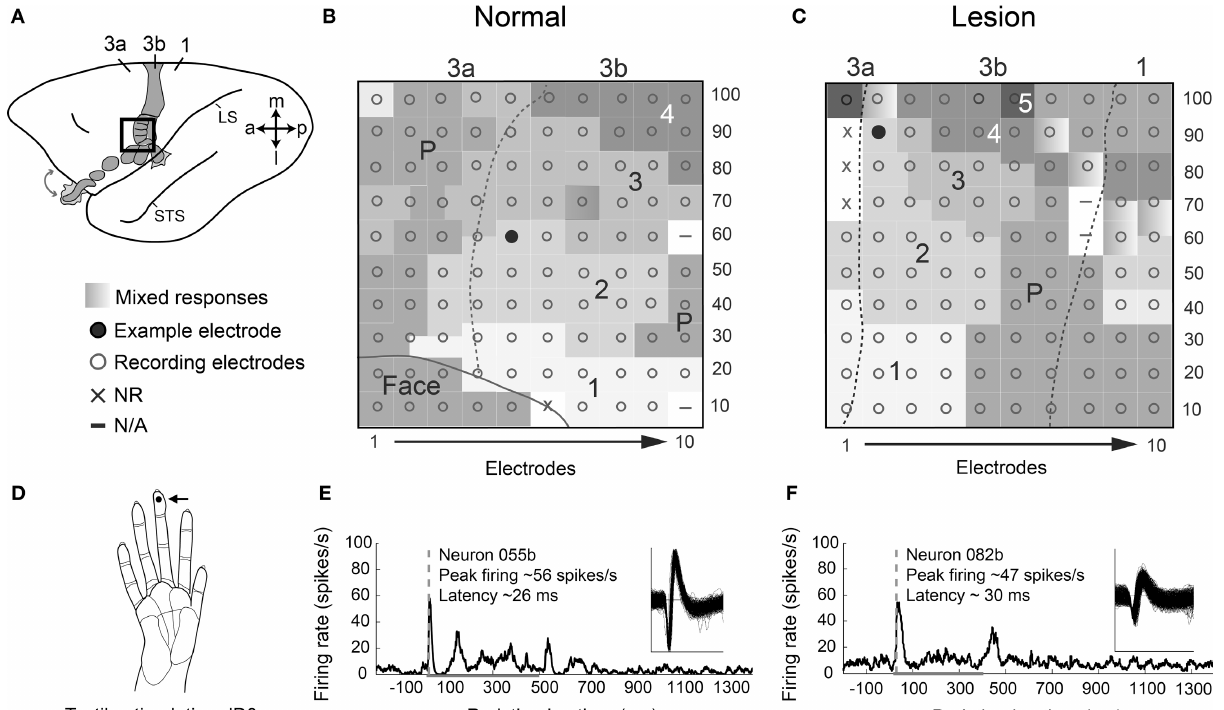
territory than D3–D5. Electrode location for the example neuron in the lower panel (F) is indicated by the filled circle. (D) Activities of neurons from monkeys with and without a lesion in (B–C) are shown in (E–F) during tactile stimulation on right distal digit 3 (dD3). The stimulation site is indicated by a dot (see arrow) on drawing of a monkey hand. (E) Example of a single unit 055b shows typical peak firing rates and latencies for an example normal case, monkey OM-A. Spikes during 100 trials of tactile stimulation on dD3 are averaged in the peristimulus-time histogram (PSTH). Waveforms of the recorded unit are shown (inset). (F) Example of a single unit 082b shows typical responses for a case with a dorsal column lesion, monkey SM-G, following recovery of reaching behavior with the impaired hand. Activity during 150 trials of tactile stimulation on dD3 is shown in the PSTH. In (B–C) , dashed lines indicate area 3b borders based on receptive field topography and myelin architecture. In (E–F) , dashed gray line indicates the latency of the peak firing response that exceeds 2 times the standard deviation of the average baseline firing. Peak firing value listed is baseline-subtracted. Horizontal gray line indicates stimulus duration in each trial (500ms in OM-A, 400ms in SM-G). Abbreviations: 1–5, digits 1–5; 3a, 3b, 1, area 3a, area 3b, area 1; a, anterior; dD3, distal digit 3; l, lateral; LS, lateral sulcus; m, medial; p, posterior; STS, superior temporal sulcus. Modified from Reed et al. (2010) and Qi et al.